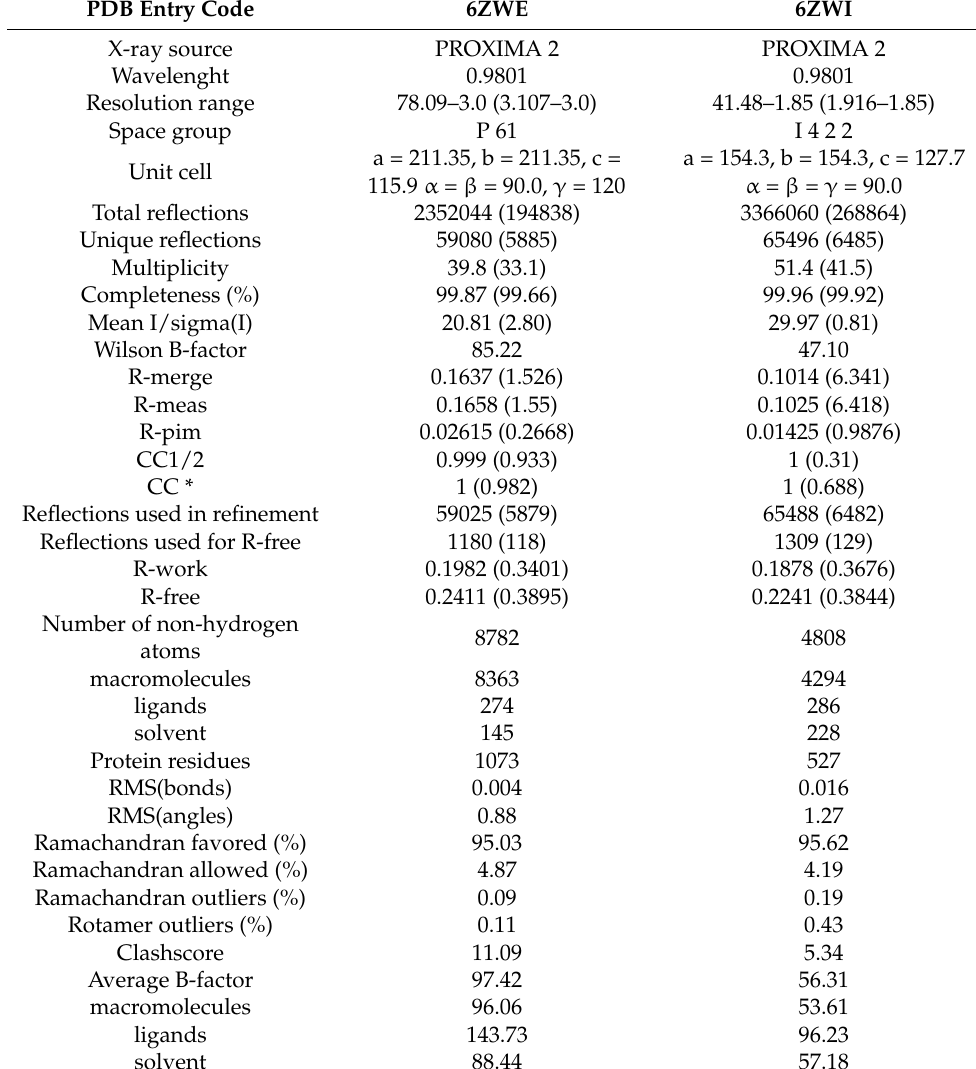
Table 1. Data collection and refinement statistics. Calculated using Phenix [39]. R-work= Σ |fo − |fc||/ Σ |fo|, fo and fc are observed and calculated structure factors, R-free set uses about thousands randomly chosen reflections. Statistics for the highest-resolution shell are shown in